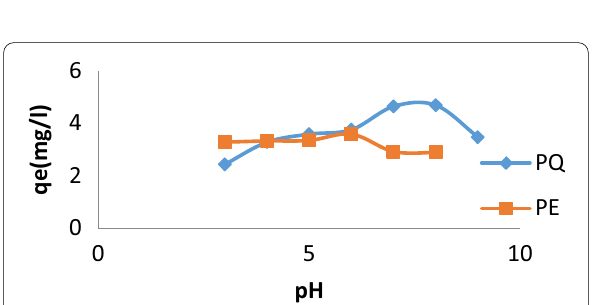
Fig. 3 Effect of pH on adsorption of PE and PQ (adsorption conditions: concentration of PE and PQ T 25 °C, volume of solution =